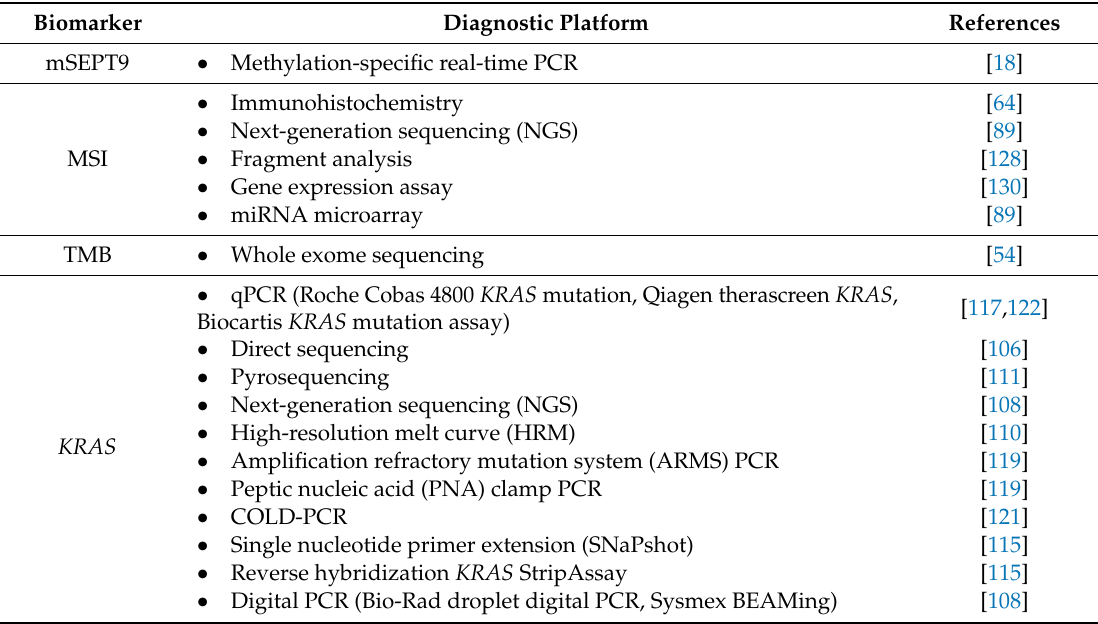
Table 2. Summary of CRC biomarkers and their respective diagnostic platforms